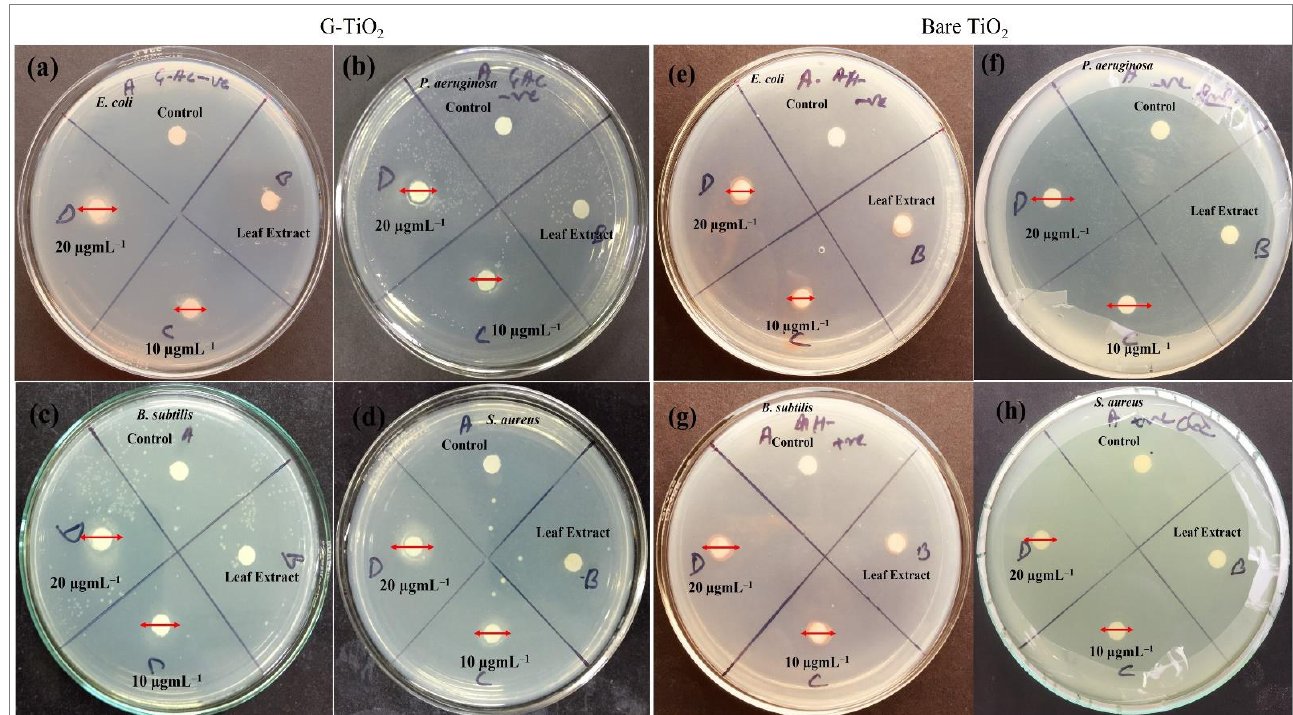
Figure 10. Assessment of antimicrobial efficiency of biosynthesized (G-TiO 2 ) and bare TiO 2 nanoparticles against Gram-negative ( a , b , e , f ) and Gram-positive bacteria ( c , d , g , h )